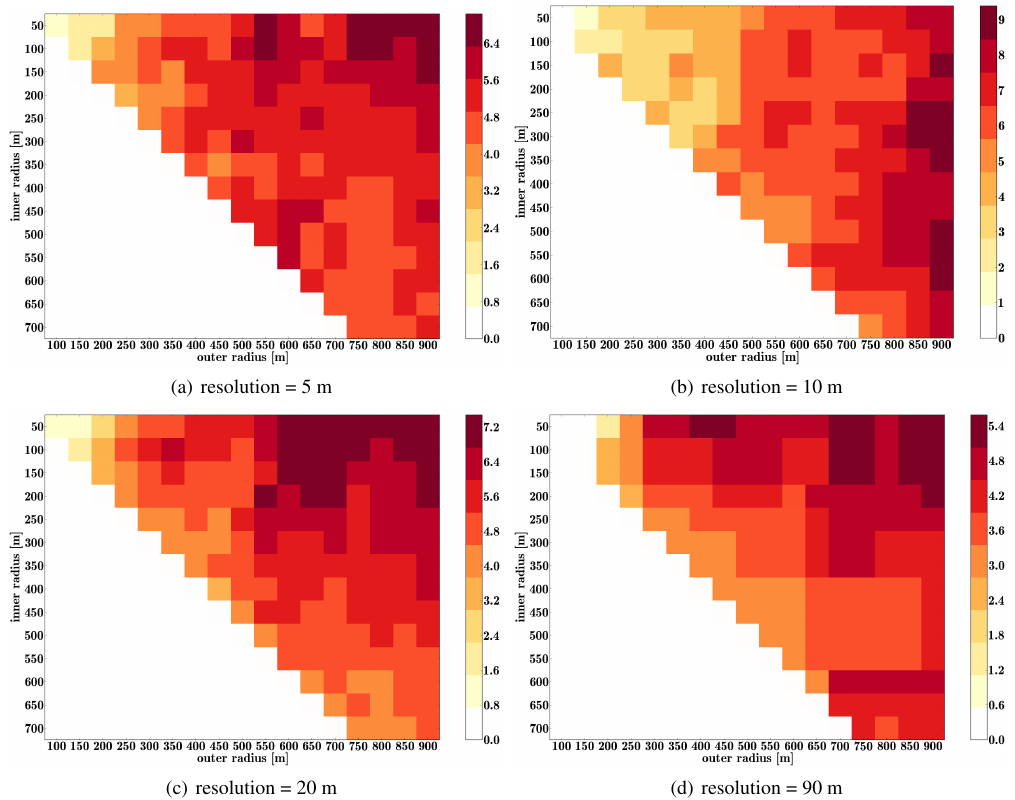
Figure 6: Variance in Claim Rates for different resolutions